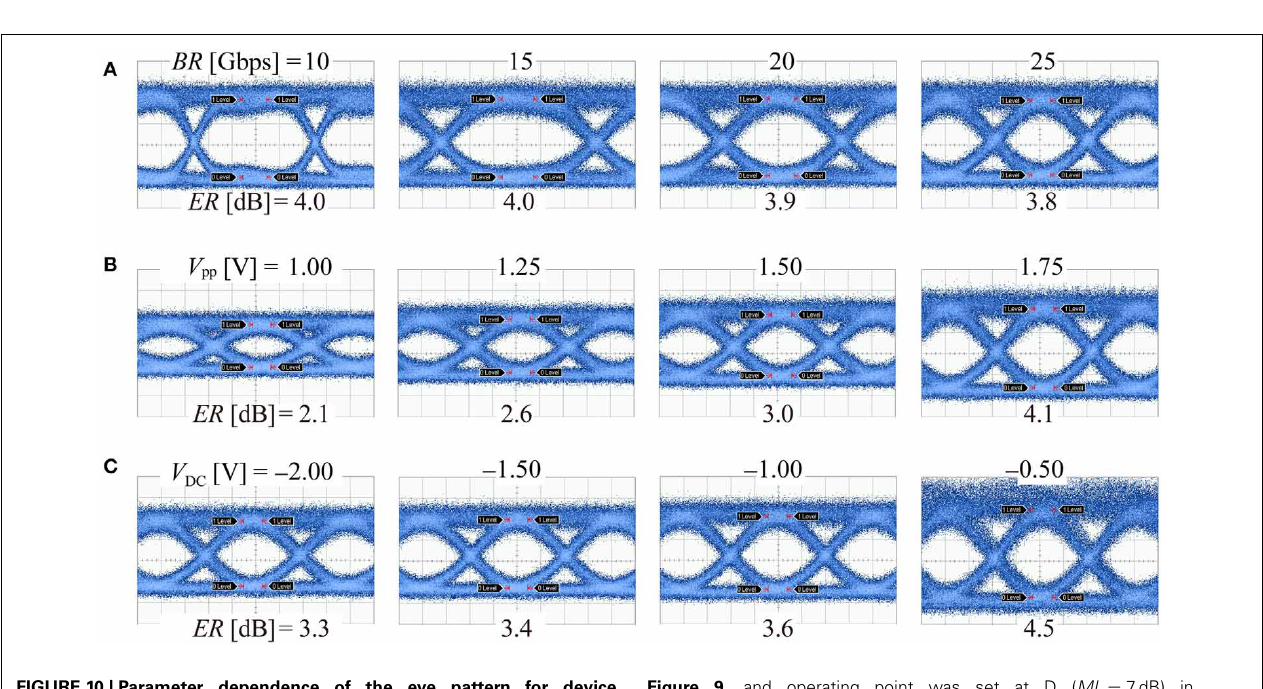
FIGURE 10 | Parameter dependence of the eye pattern for device #1 with liner junction and middle doping concentration. Basic settings, and measurement condition are the same as those for